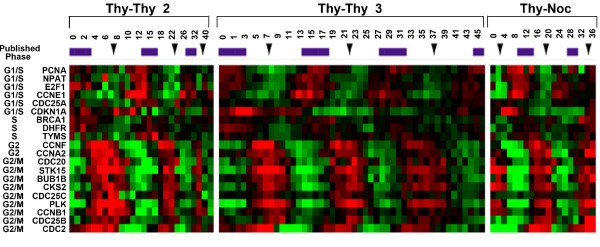
Gene expression during the HeLa cell cycle. Each gene corresponds to a row, and the time point (minutes) for each column is denoted. The magnitude of mRNA expression ratio for each gene is represented by different colours. Red indicates mRNA abundance; green indicates a dearth; and gray indicates absence of the data. On the top bar(s), S phase and the time of mitoses (the arrows) are indicated, which was estimated by flow cytometry and BrdU (bromodeoxyuridine) labeling previously.